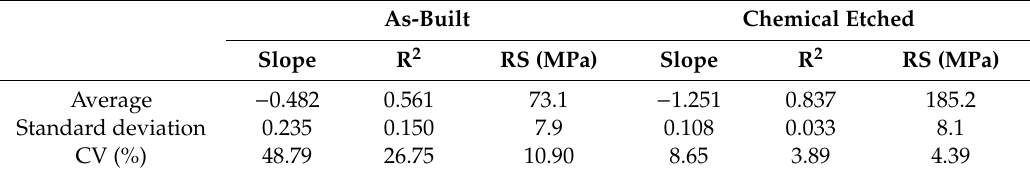
Figure 3. Plots of 2 θ –sin 2 ψ for XRD measurements performed on as-built samples ( a , b ) and chemical-etched samples ( c , d ). Data points of single measurement was shown in ( a , c ) and a superposition of all data points obtained in eight measurements was shown in ( b , d ). Table 4. Statistics of data obtained from XRD measurements: slope and coe ffi cient of determination (R 2 ) of the fitted 2 θ -sin 2 ψ straight line as well as the resulting residual stress (RS). Coe ffi cient of variation (CV) is defined as the ratio of the standard deviation to absolute value of the